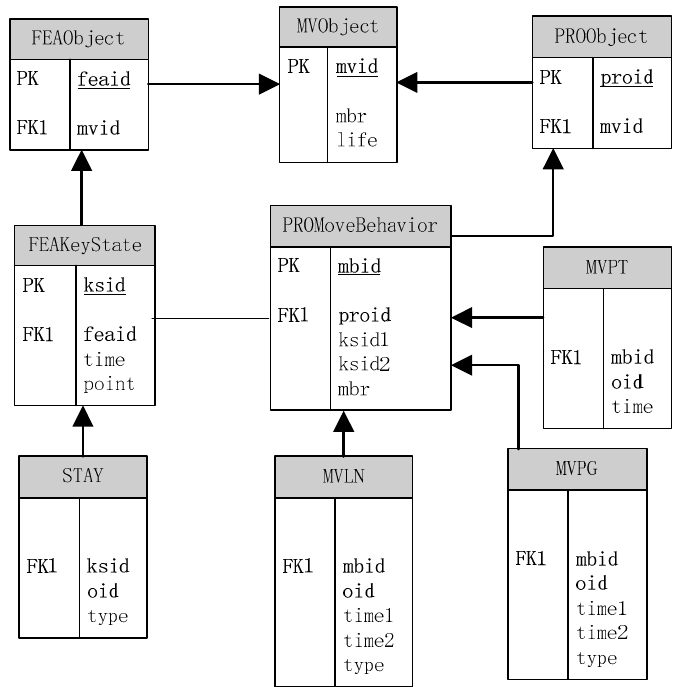
Figure 5. The model of correlation between the movement and geospatial elements.